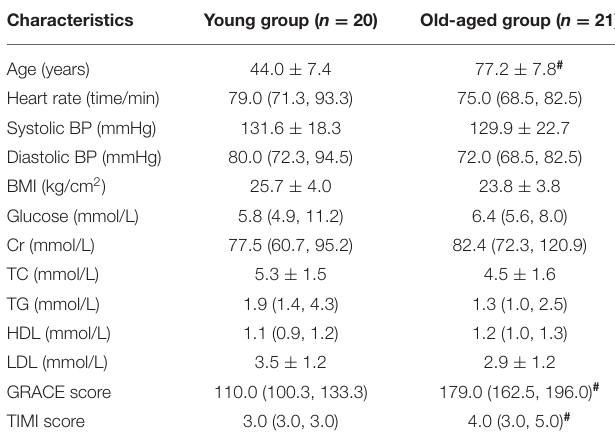
TABLE 1 | Clinical and biochemical characteristics in young and old-aged male